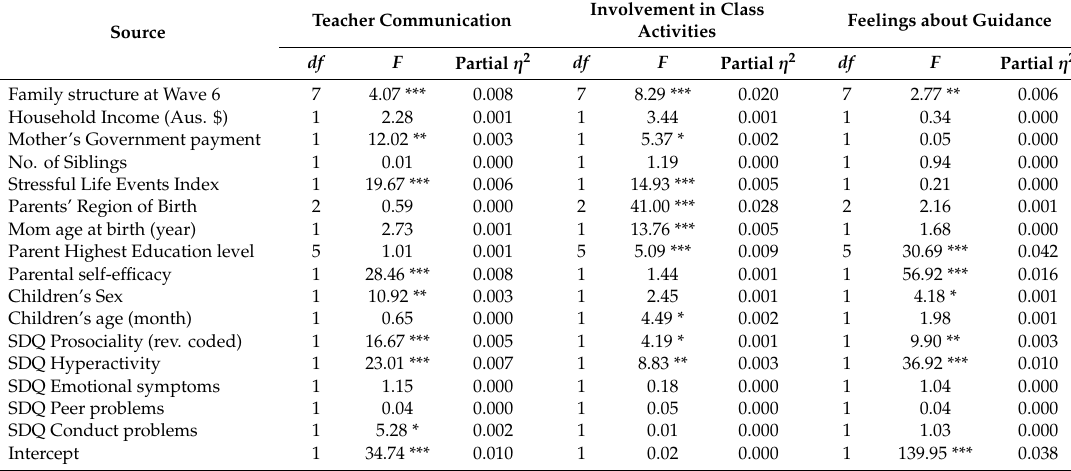
Table 5. ANCOVA results of three parent’s involvement subscales